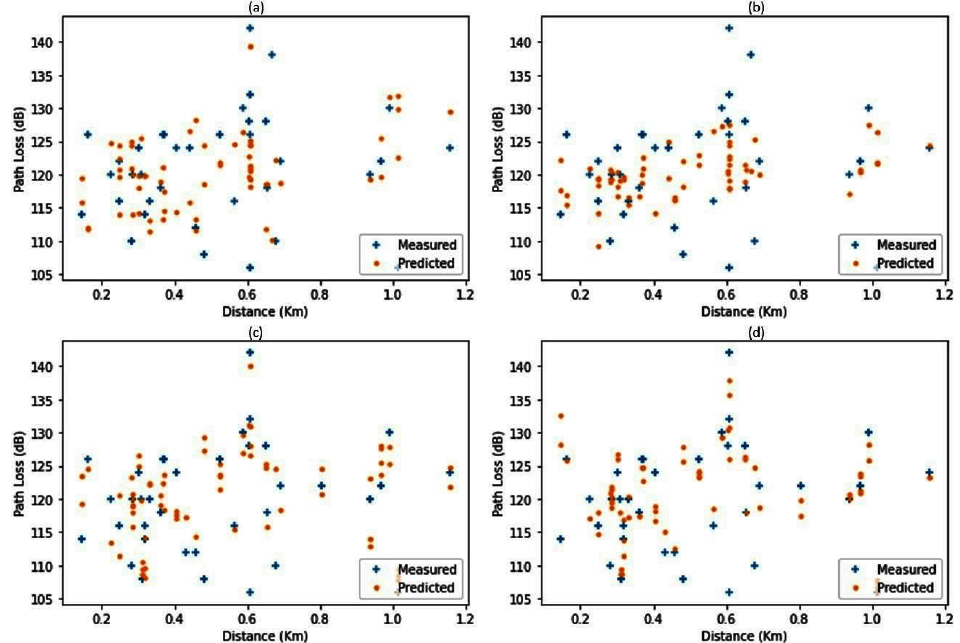
Figure 19. Predictions in urban (2100 MHz) environment based on ( a ) DRS on dataset 1, ( b ) DES on dataset 1, ( c ) DRS on dataset 2, ( d ) DES on dataset